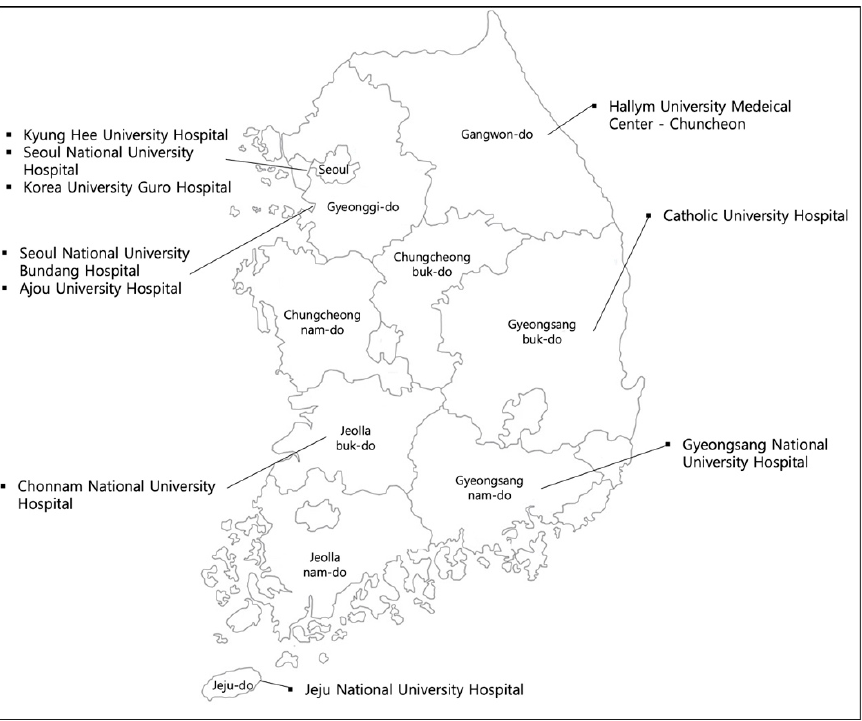
Figure 1. Ten study centers selected for the Korean Frailty and Aging Cohort Study (KFACS).